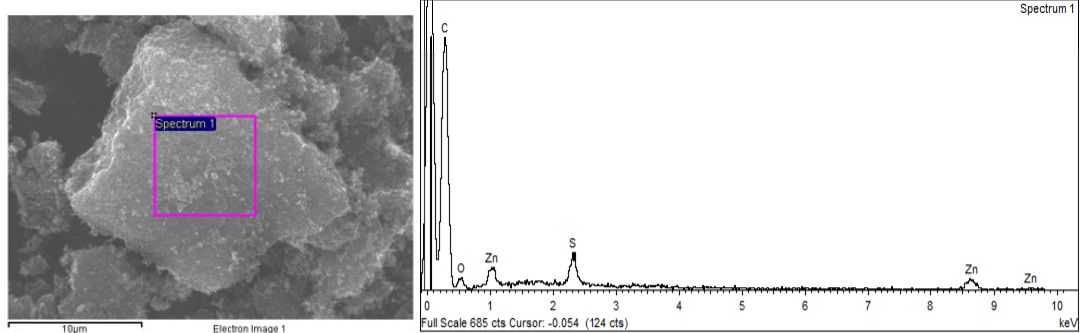
Figure 5. SEM images of char particles with a magnification of 4000× ( left ) and EDS spectra ( right ).